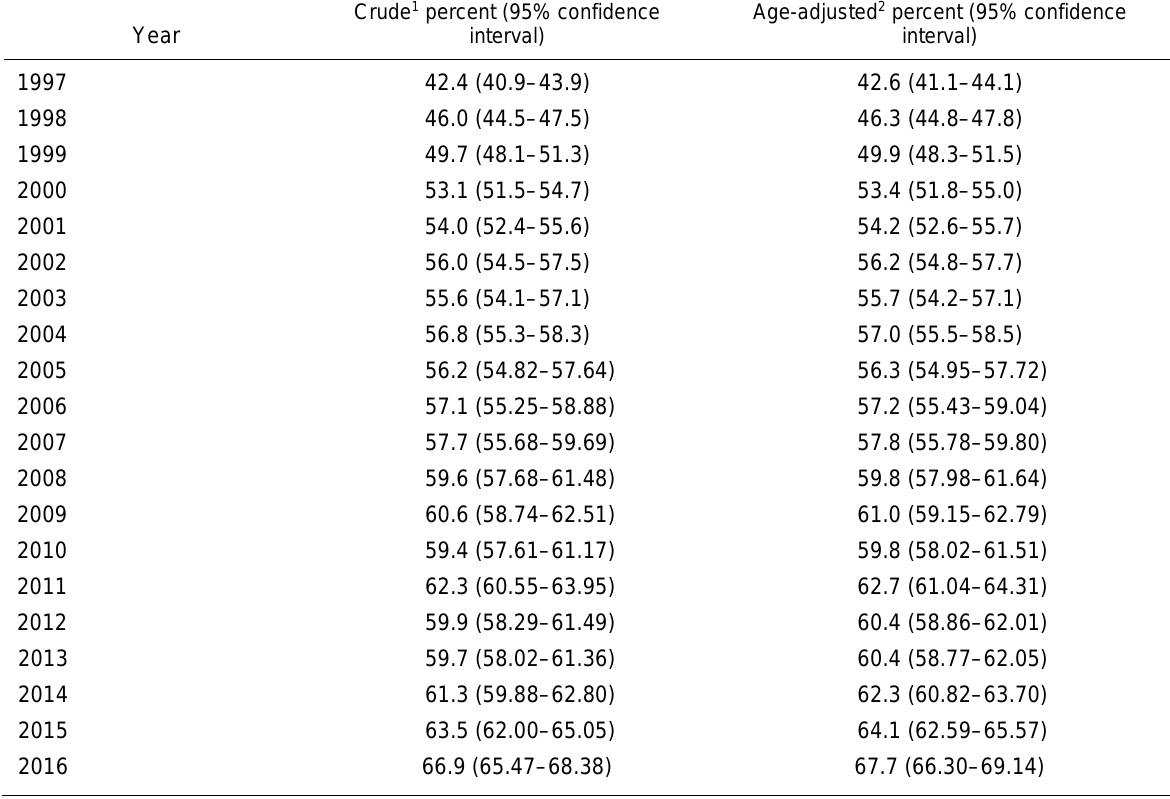
Data table for Figure 5.1. Percentage of adults aged 65 and over who had Data tables for Figures 5.1–5.3: